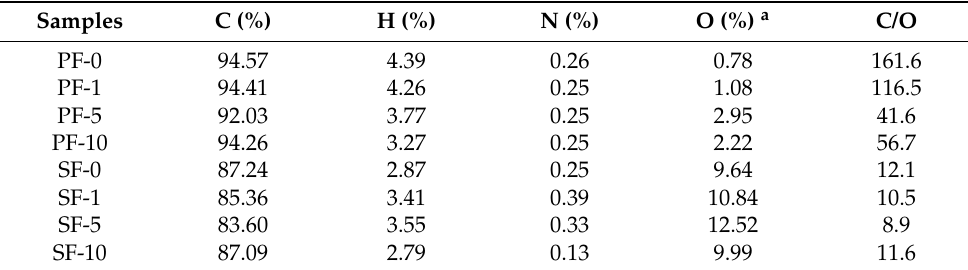
Table 2. Elemental Analysis and C/O Ratio of Different PIM-Derived Pitch Fibers and Stabilized fibers.